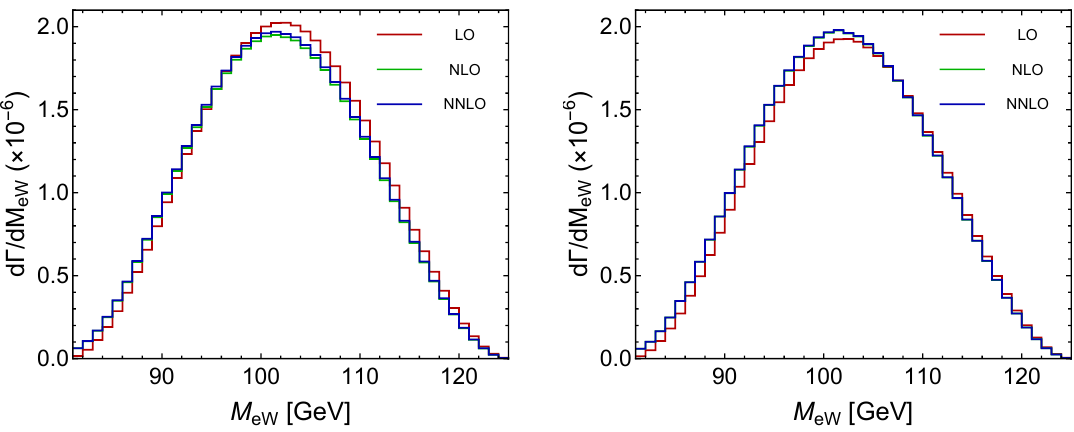
Figure 3 . The M eW distribution in the α ( m Z ) scheme (left) and in the G µ scheme